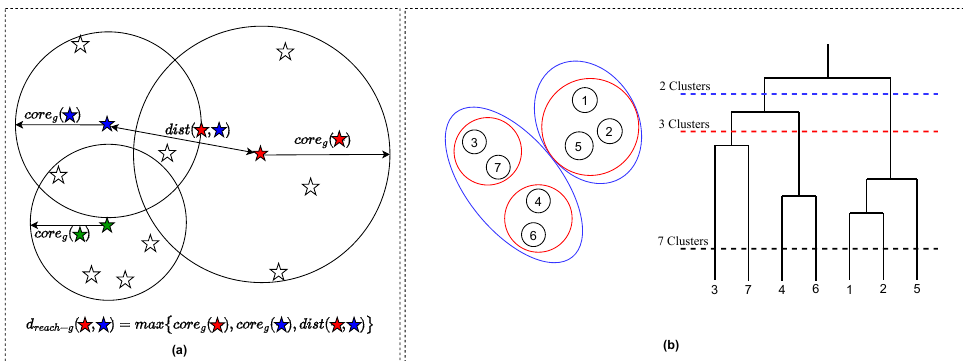
Figure 4. A concept of HDBSCAN clustering algorithm. ( a ) Mutual reachability distance computation from three clusters bearing varied densities. ( b ) Agglomerate dendrogram showing significant clusters that can be